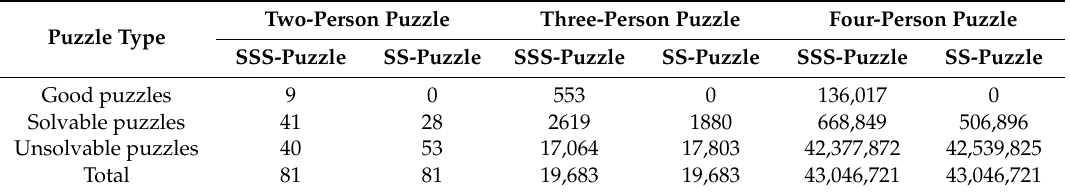
Table 3. The number of good, solvable (including good ones), and unsolvable Strong Truth-Teller–Strong Liar (SS)- and Strong Truth-Teller–Strong Liar–Strong Crazy (SSS)-puzzles with two, three and four persons.